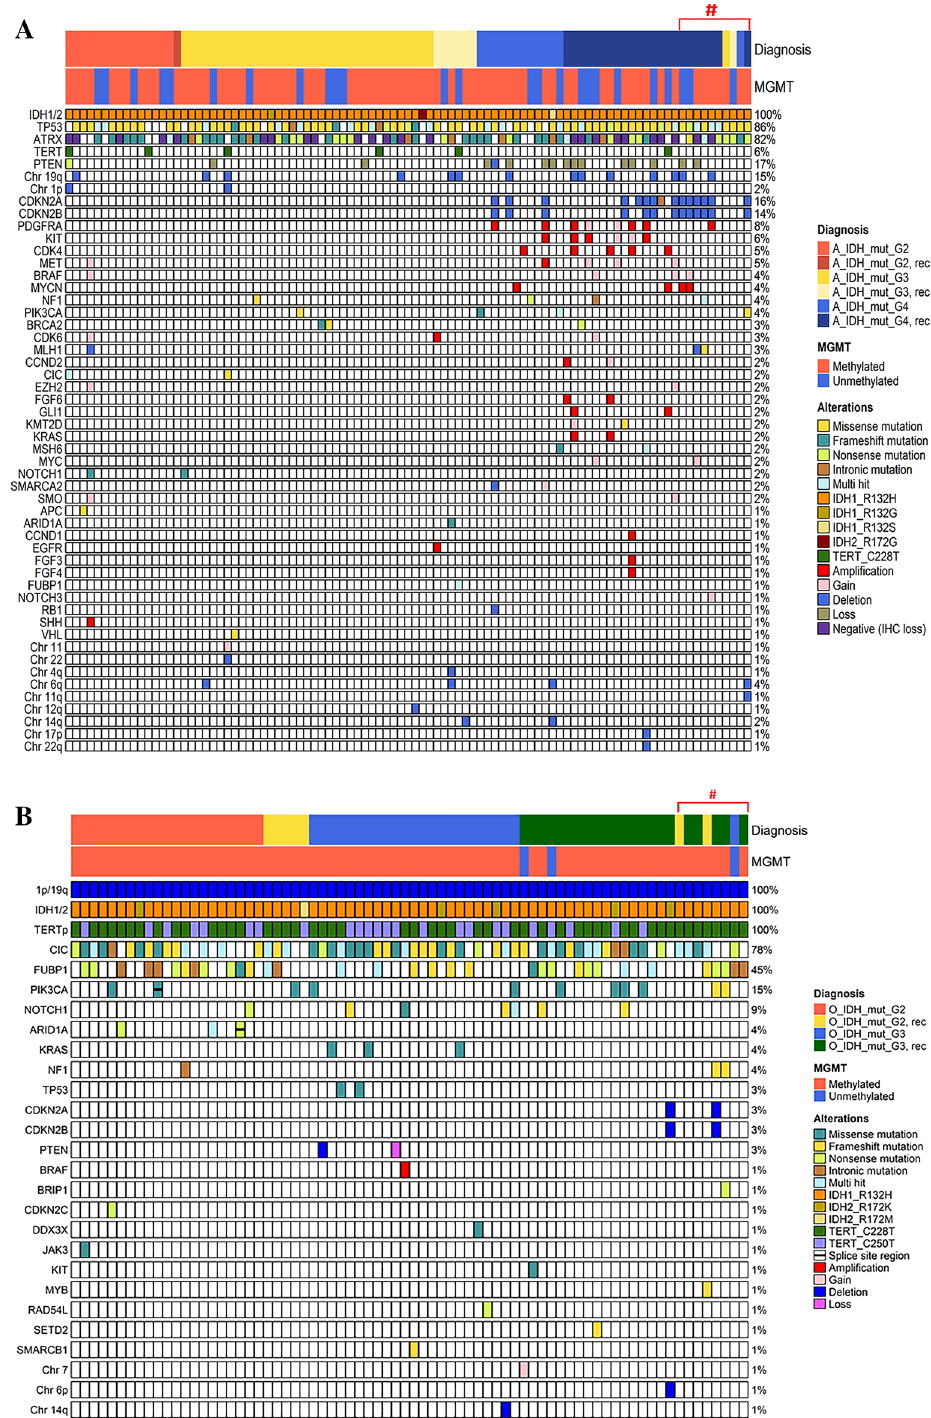
Figure 1. ( A ) The oncomap of IDH-mutant astrocytomas (n = 95) and ( B ) oligodendrogliomas (n = 74) of this study. The NGS study was performed twice on sequentially removed 18 tumors from 5 patients with A_IDH_ mut and 4 patients with O_IDH_mut